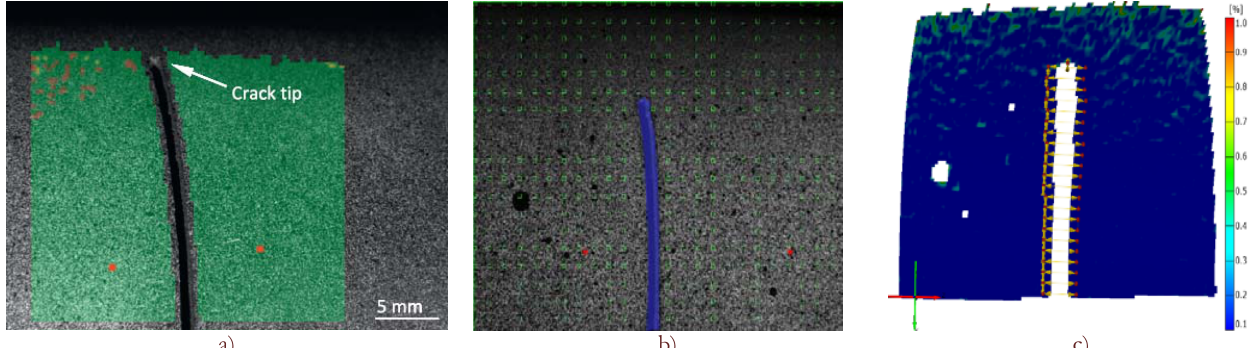
Figure 2: Example of processed DIC images: a) in green the analysis area red dots are the virtual clip gauge ends; b) in blu the crack and green squares shows the grid for strain measurements; c) the resulting strain